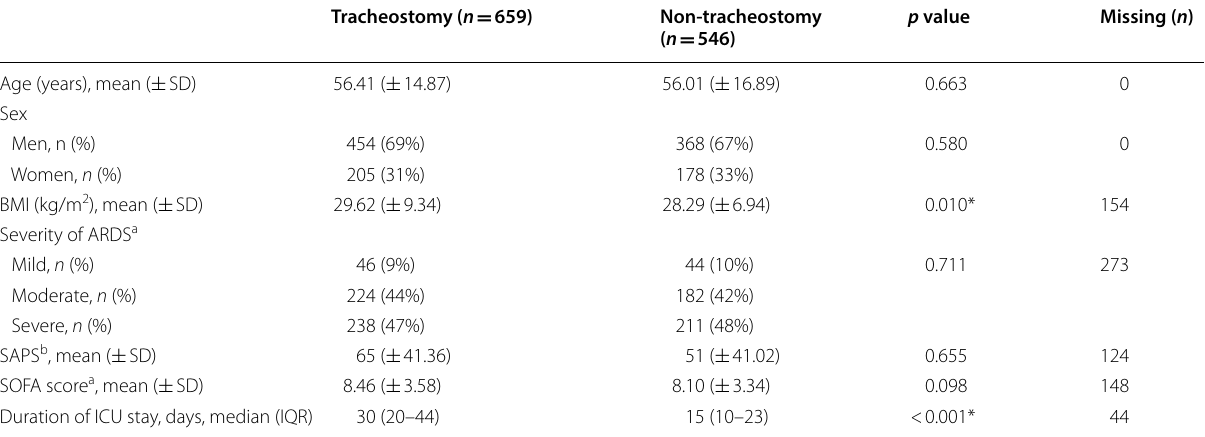
Table 1 Patient characteristics of the ICU sample ( n